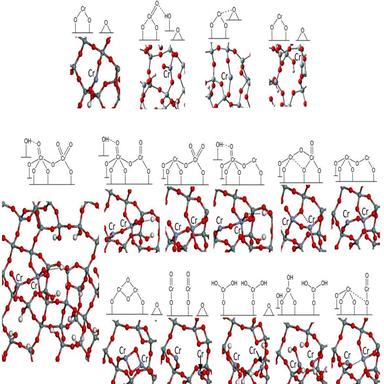
Example models of monomeric (top) and dimeric (bottom) Cr oxide species at various oxidation states on the partially dehydroxylated silica surface. Adapted from ref.. Copyright © (2017) with permission from Elsevier.